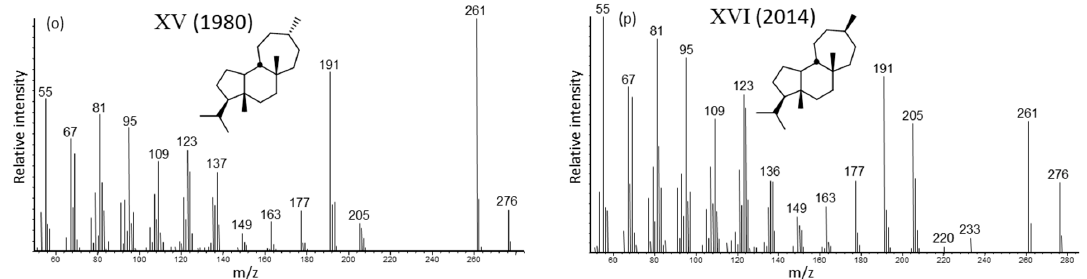
Figure 3. Mass spectra of the diterpenoid hydrocarbons in A. compacta resins. The KI values relative to n ‐ alkanes on a DB ‐ 5 column are shown in parentheses on each mass spectrum: ( a ) 20 ‐ normulina ‐ 11,13 ‐ diene (III), ( b ) 20 ‐ norazorell ‐ 13 ‐ ene (IV), ( c ) 13 β (H) ‐ 20 ‐ normulinane (VI), ( d ) 13 α (H) ‐ 20 ‐ normulinane (VI), ( e ) 13 β (H) ‐ 20 ‐ norazorellane (V), ( f ) 13 α (H) ‐ 20 ‐ norazorellane (V), ( g ) azorell ‐ 13 ‐ ene